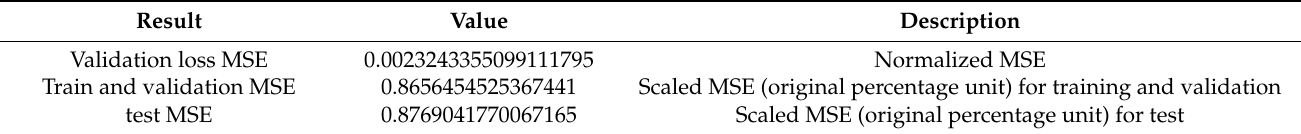
Table 3. Best model result.